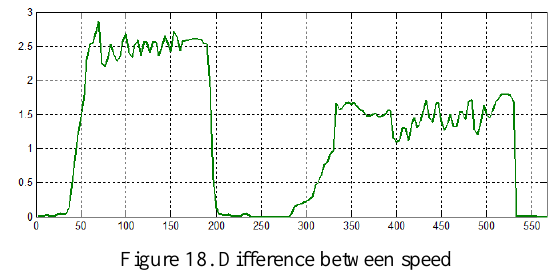
Figure 18. Difference between